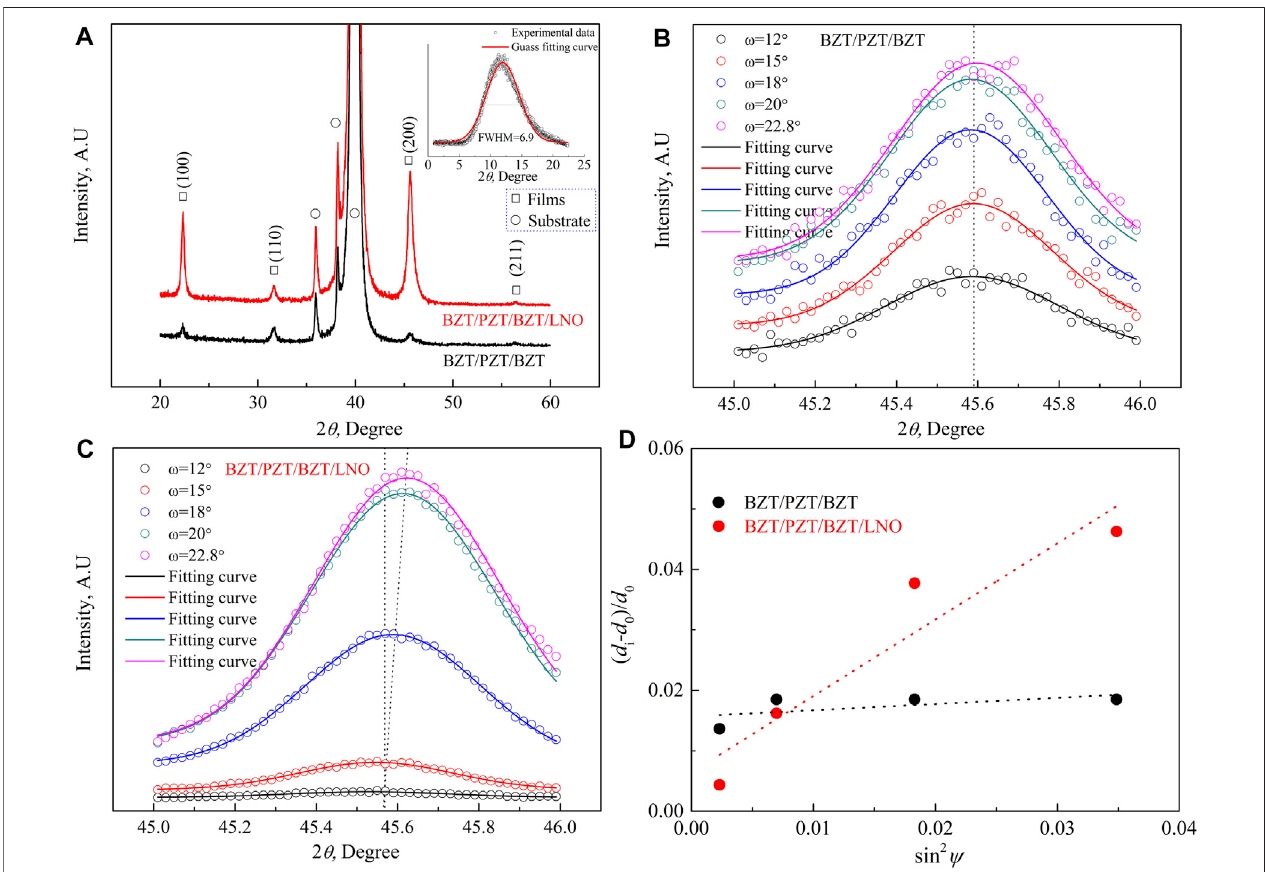
FIGURE 1 | XRD patterns of the BZT/PZT/BZT multilayer fi lms. (A) θ – 2 θ scan patterns; the inset is the rocking curve patterns. (B, C) GIXD of (001) peaks of BZT/ PZT/BZT and BZT/PZT/BZT/LNO multilayer fi lms. (D) Dependence of the interplanar crystal spacing on sin 2 ψ .